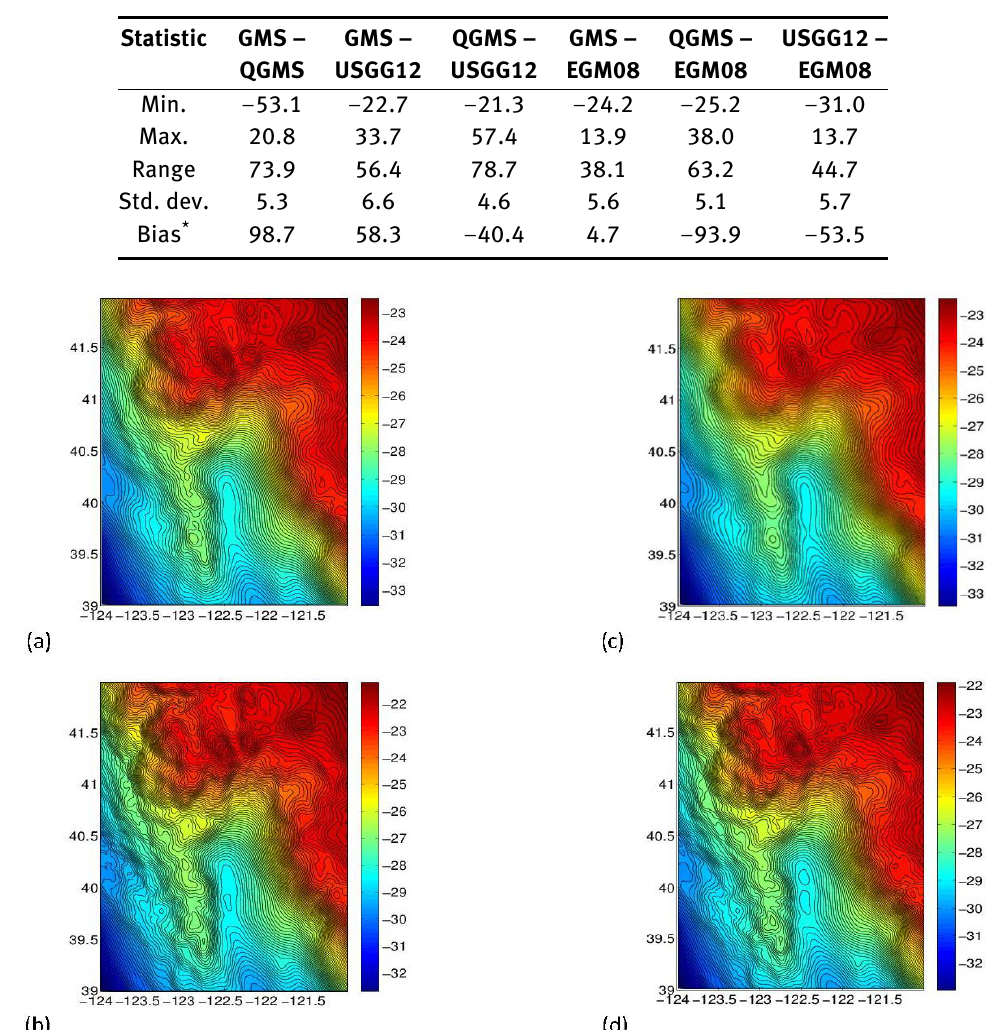
Table 5: Statistics of the differences between the different geoids for the California test area. Unit is in cm